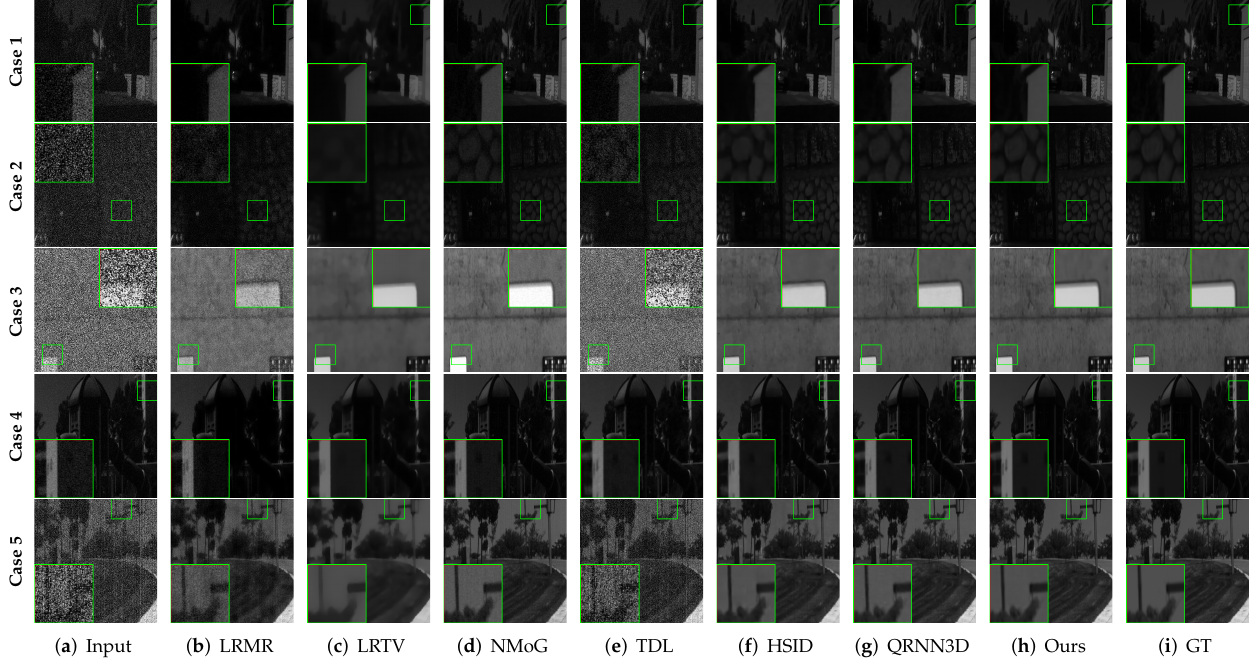
Figure 11. Qualitative comparison of the six denoising methods on the ICVL dataset, where the first column is noisy HSI, and the last column is the corresponding